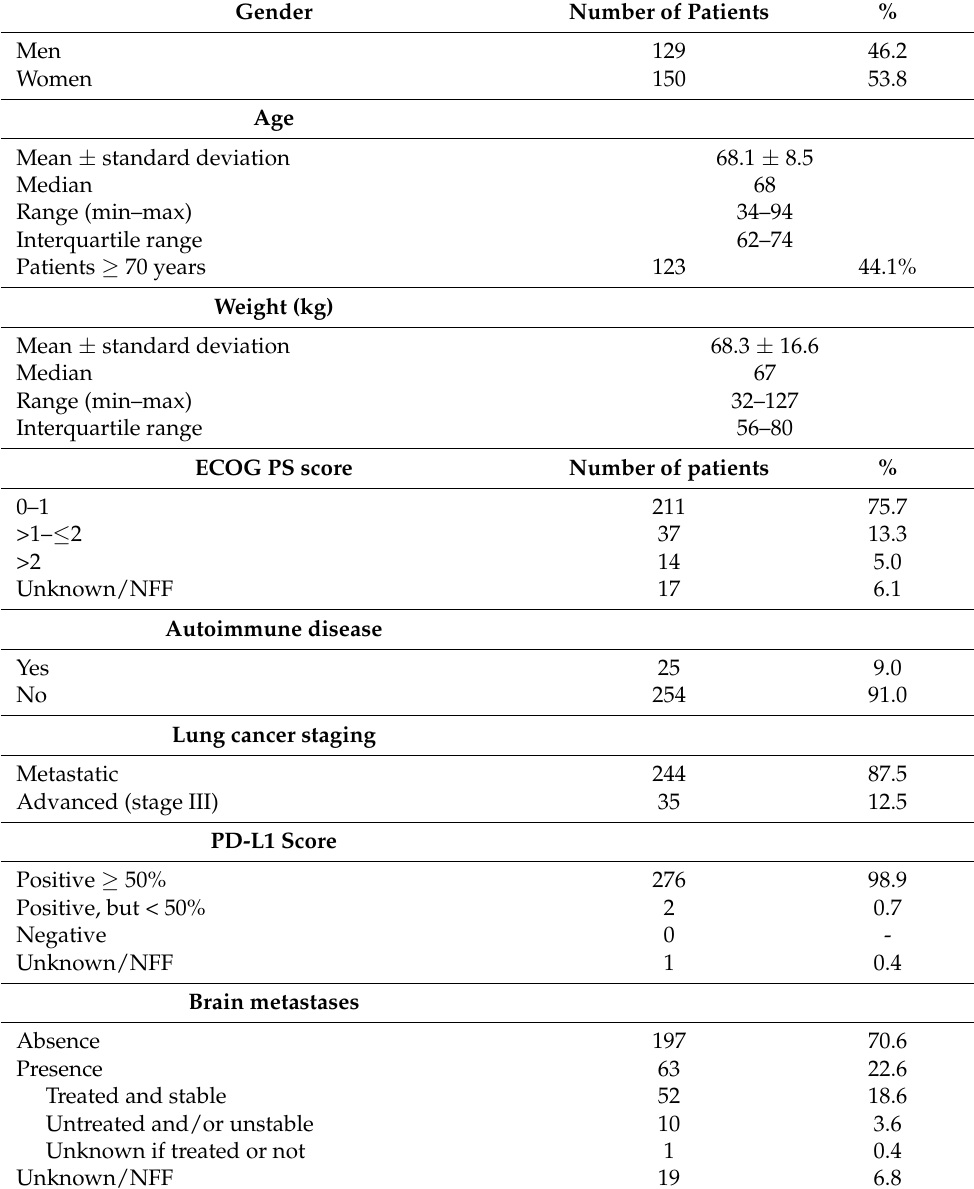
Table 1. Patient characteristics ( n = 279) at treatment initiation with